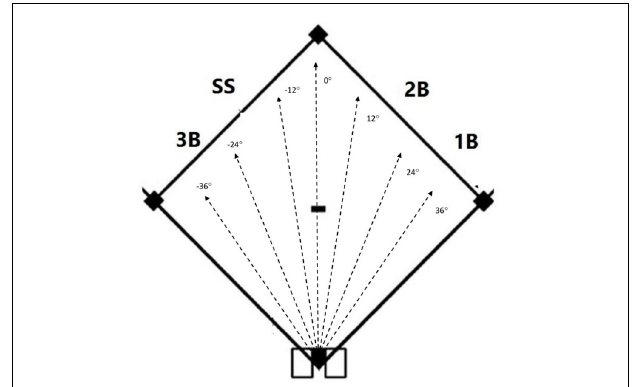
FIGURE 2 | Illustration of the hit trajectories used in the videos. On each trial, a ball was launched onto the ground from home plate (black diamond at bottom of figure) at one of 7 possible angles (dashed lines) with an angle of 0 ◦ being a ball hit directly straight ahead over second base (black diamond at top of figure). The 1B (first baseman), 2B (second baseman), SS (shortstop), and 3B (third baseman) show the approximate positions of the four cameras.